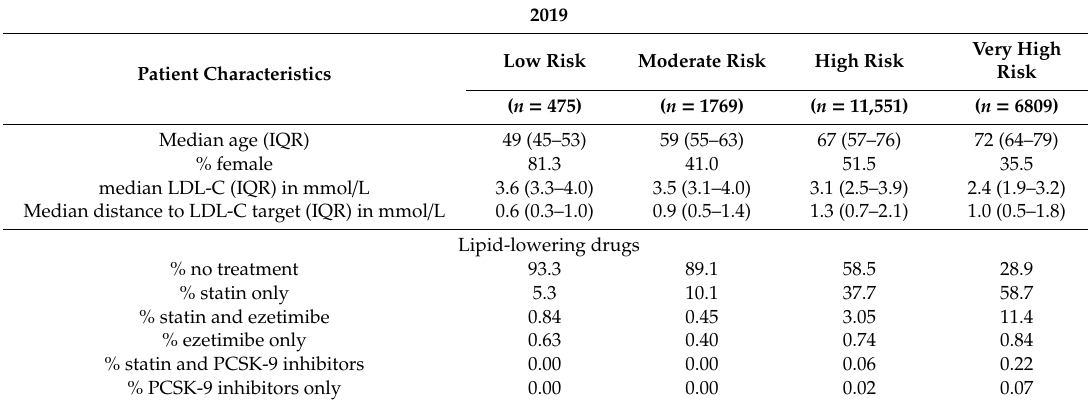
Table 2. Characteristics of patients not achieving LDL-C target values according to the 2019 ESC / EAS guideline (total number of patients =